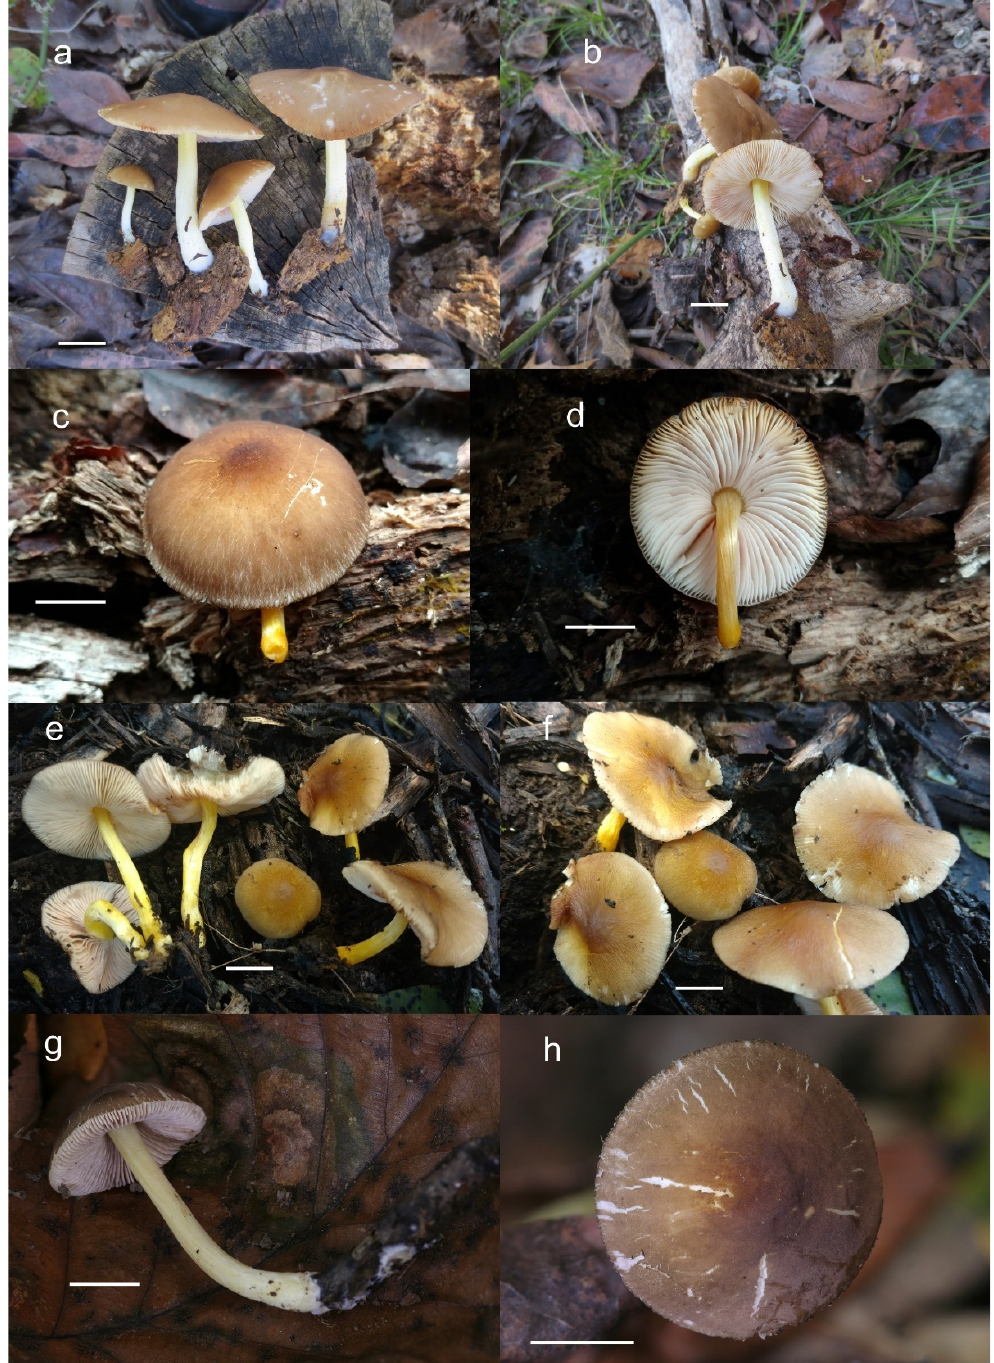
Figure 10. Pluteus austrofulvus basidiomata in situ: ( a , b ). AJ 857 (holotype), ( c , d ). iNaturalist 112016967, ( e , f ). iNaturalist 112219822, ( g , h ). iNaturalist 112280046. Scale bars 1 cm.